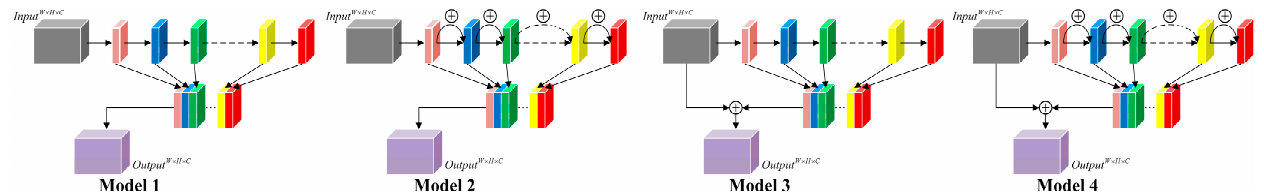
Figure 13. The structure of DenseRes Block in each detector in Table 3.